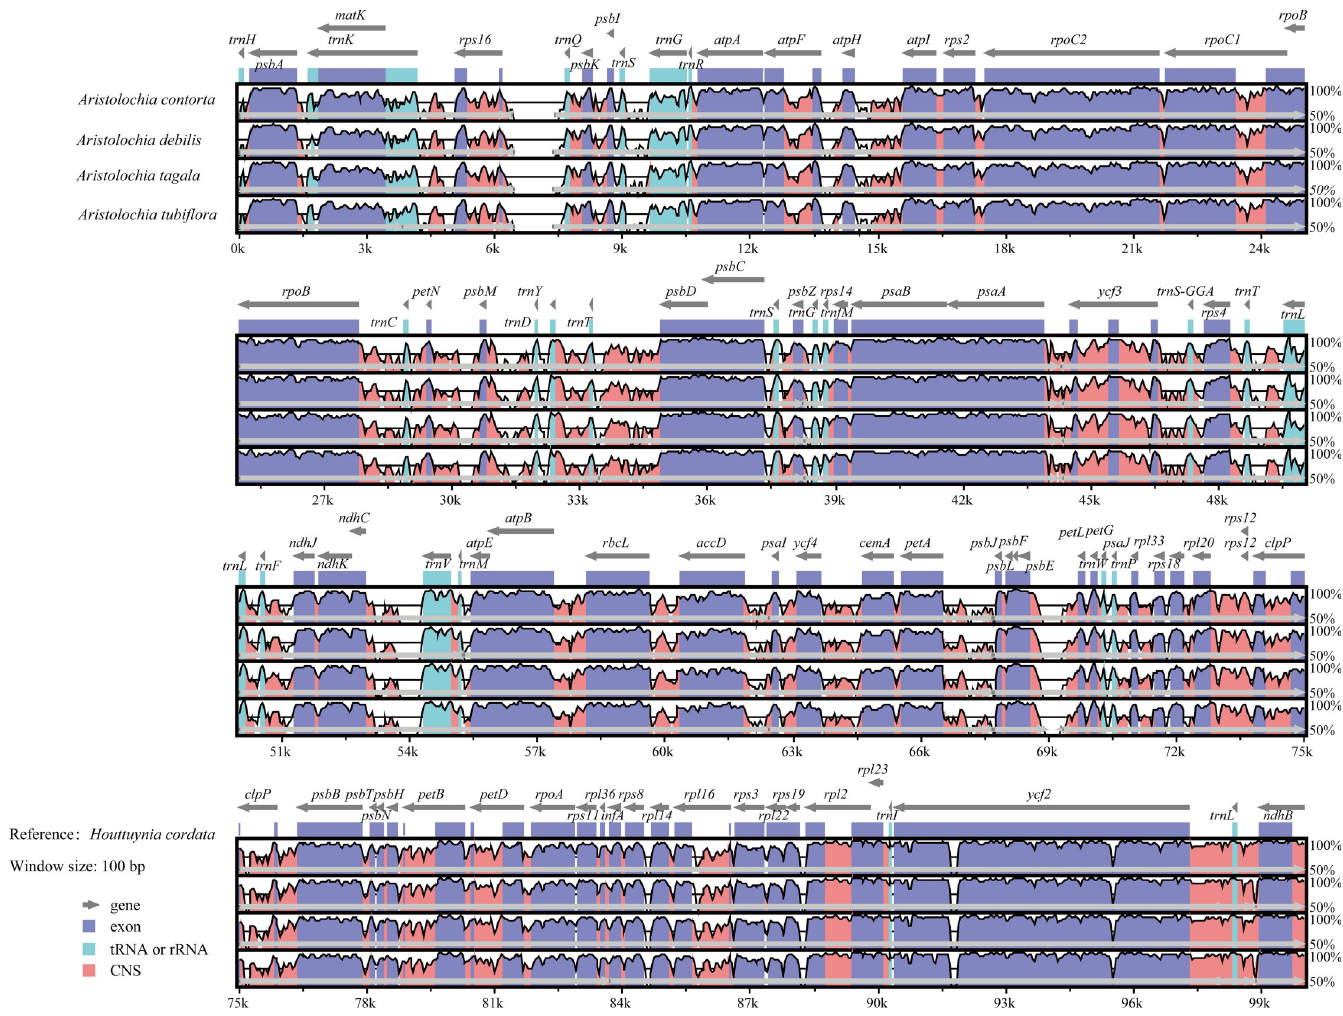
Fig 5. Alignment of the cp genomes of H . cordata and four closely related species. The alignment was performed by mVISTA with H . cordata as a reference. Local collinear blocks within each alignment are indicated by the same color and linked.